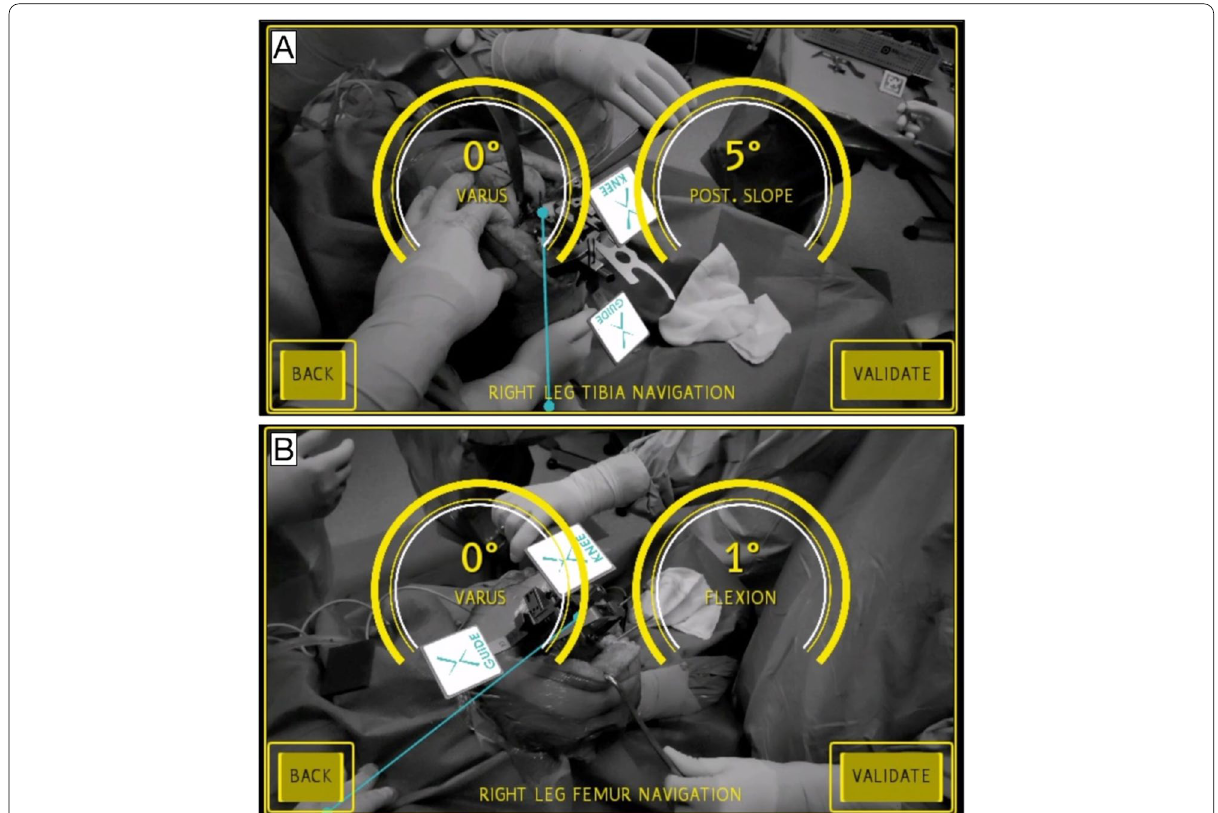
Fig. 3 The Knee system enables the surgeon to view the tibia ( A ) and femur ( B ) mechanical axis (blue line) superimposed on the tibia and femur + on surgical field. In yellow circles, it has been indicated the coronal and sagittal alignment of cutting guide